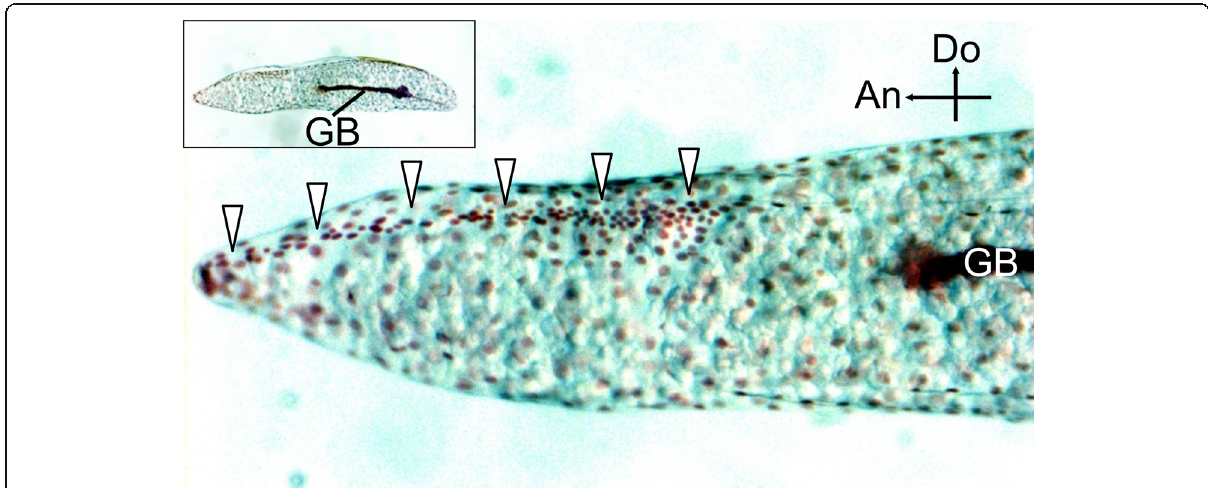
Fig. 6 Prior casting of the hatching line by serosal cells during early embryogenesis. Nuclei in the germ-band (GB) elongation stage (20 days after oviposition) were visualized by Feulgen staining. An image of the whole egg is displayed in the inset. The nuclei of serosal cells were distinctly gathered along the developing hatching line (arrowheads). Crossed arrows indicate the anterior (An) and dorsal (Do) directions